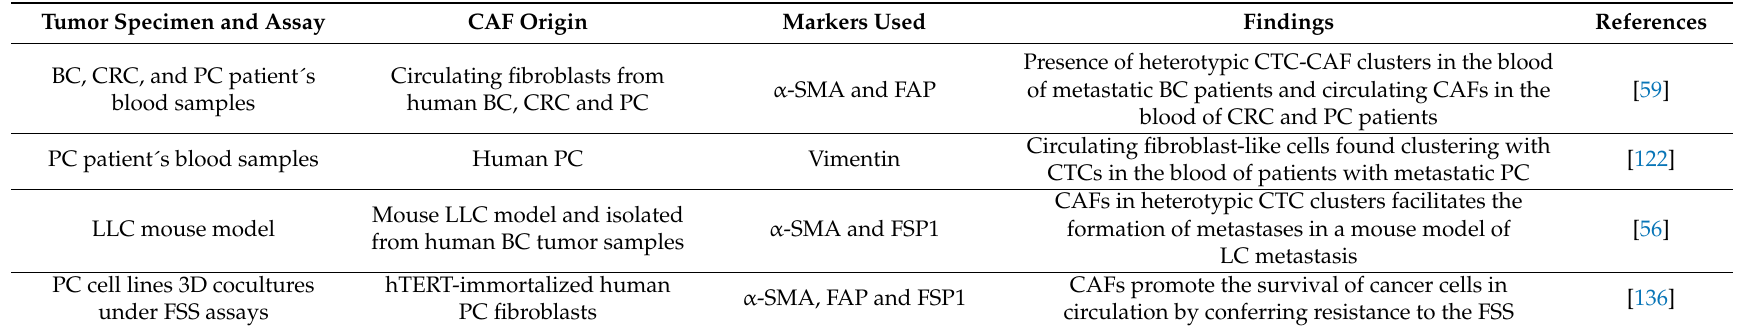
Table 2. Evidence of the contribution of CAFs to the metastatic potential of CTC